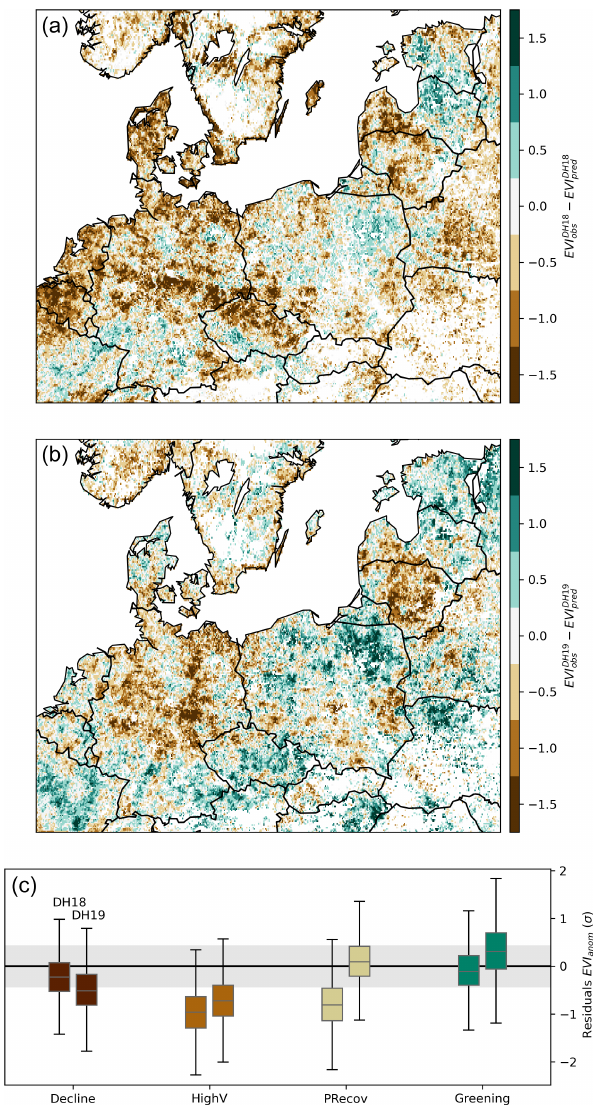
Figure 5. Spatial distribution of EVI anom residuals in DH18 (a) and DH19 (b) estimated by the temporal RF model trained for 2001– 2017 with spring and summer SM anom and T anom as predictors. The corresponding distribution per cluster for each DH event is shown by the boxplots in panel (c) . The shaded grey envelope indicates the range of residuals in the training period.